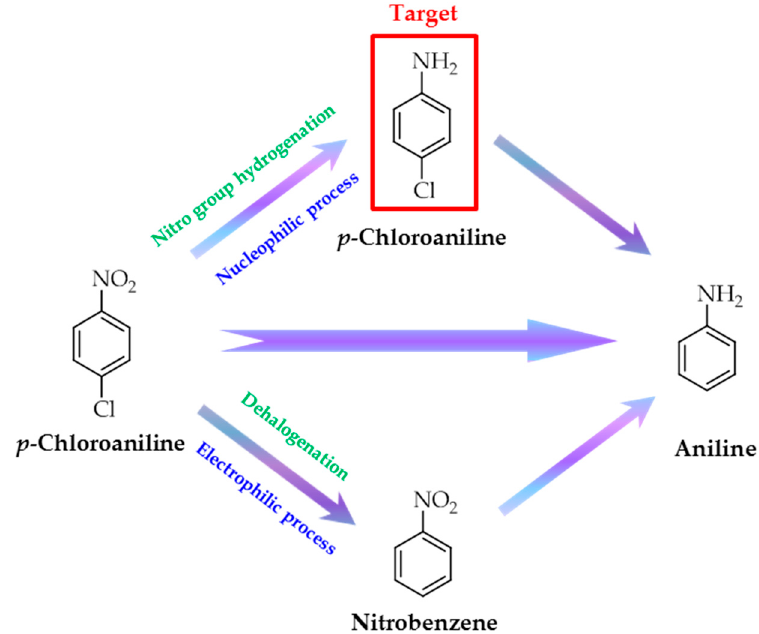
Figure 1. Main pathways associated with the selective hydrogenation of p ‐ CNB ( p ‐ chloronitrobenzene).